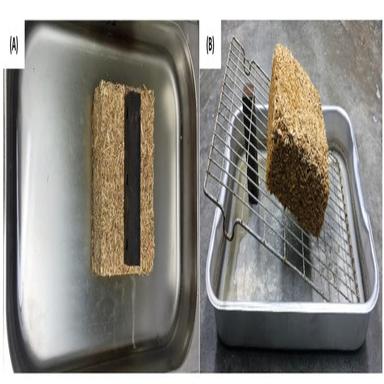
Water absorption test showing (A) sample placed in water for 24 h, (B) draining at an inclined angle.